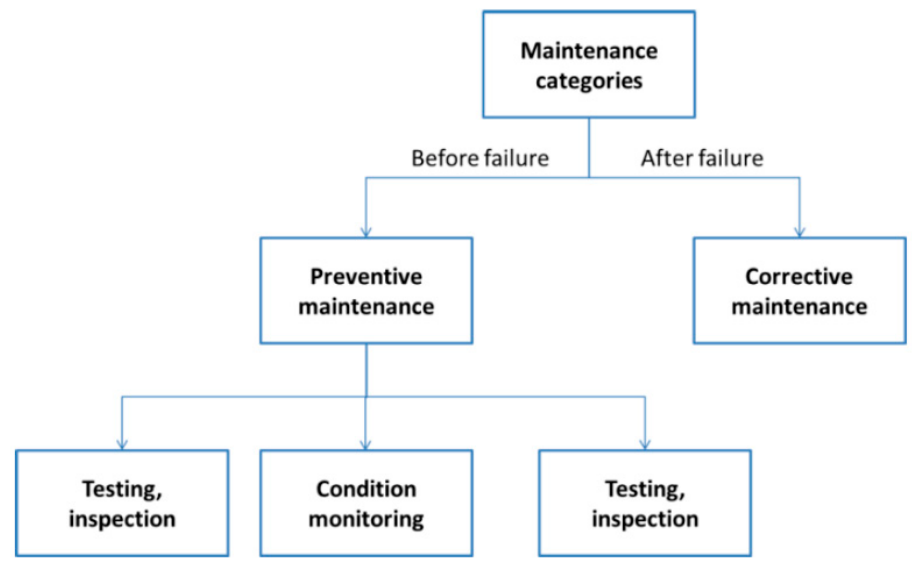
Figure 3. Maintenance actions of OPERA O&M Model [37].